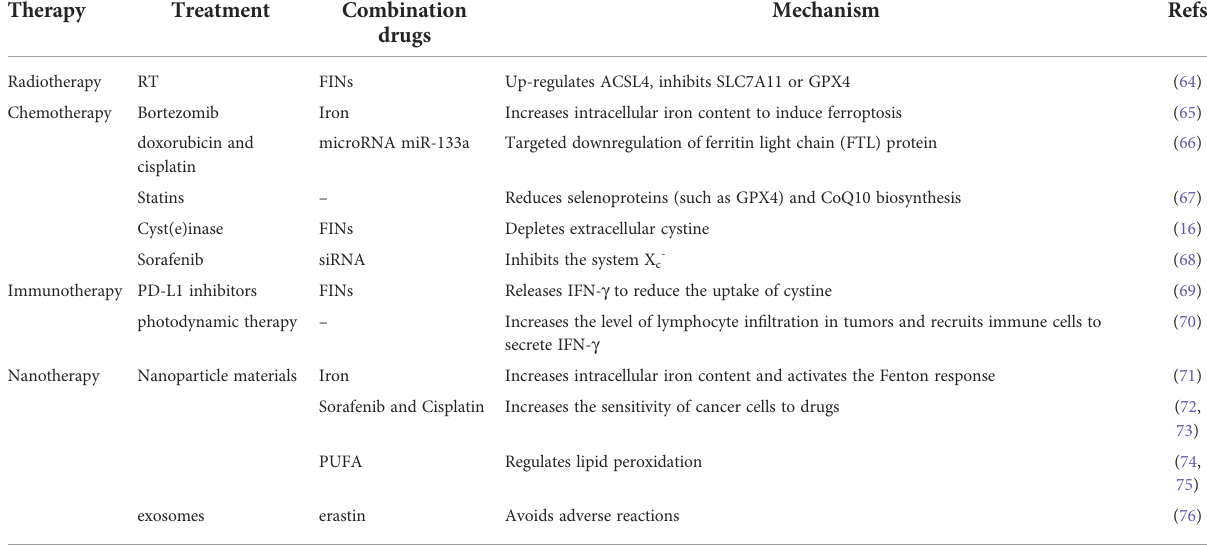
TABLE 2 This table summarizes examples of radiation therapy, chemotherapy, immunotherapy, and other combination of treatments, and brie fl y describes the mechanism.